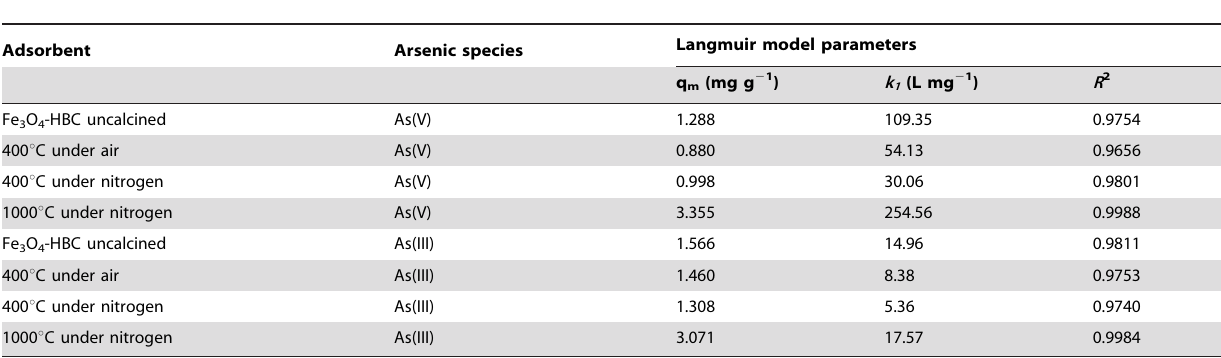
Table 3. Langmuir model parameters for the adsorption of As(V) and As(III) on Fe 3 O 4 -HBC composite at ambient temperature (25 6 0.8 u